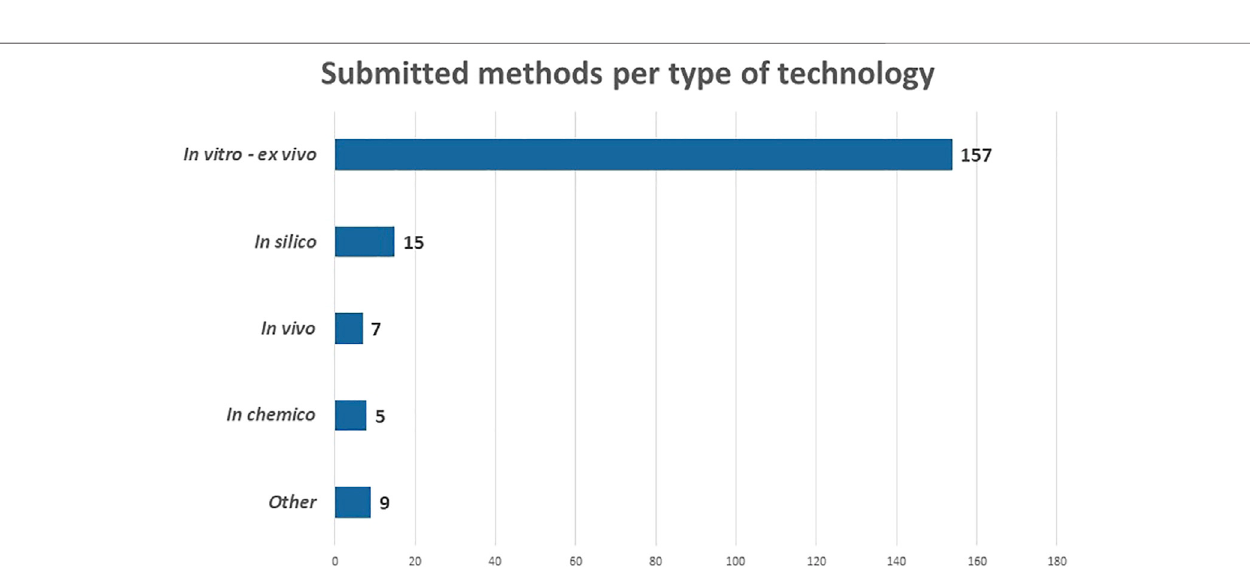
FIGURE 4 | Submitted methods according to the type of technology in May